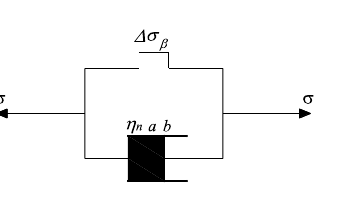
Figure 12. Nonlinear viscoplastic model.